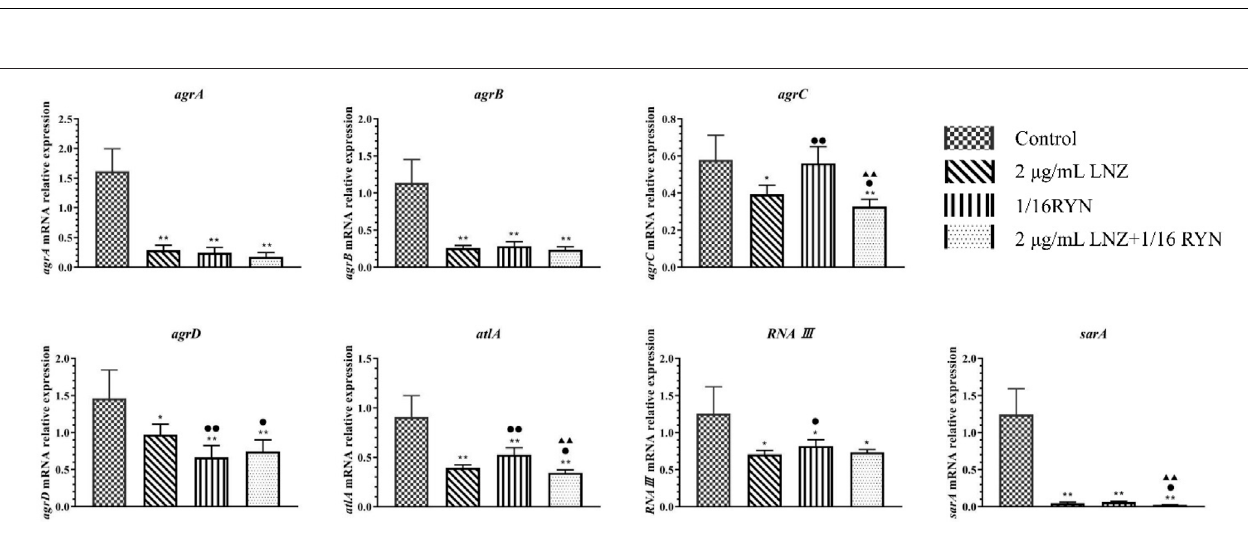
FIGURE4| mRNA expression ofbio fi lm-related genesafter differentdrug treatments.(** p < 0.01, * p < 0.05 vs . control group; ▲▲ p < 0.01, ▲ p < 0.05 vs. 1/16RYN group; CC p < 0.01, C p < 0.05 vs. 2 μ g/ml LNZ group.). Compared with the control group, the gene expression decreased after drug intervention. The expression of agrC , atlA and sarA decreased signi fi cantly compared with LNZ and RYN alone under the intervention of the combination of the two drugs.